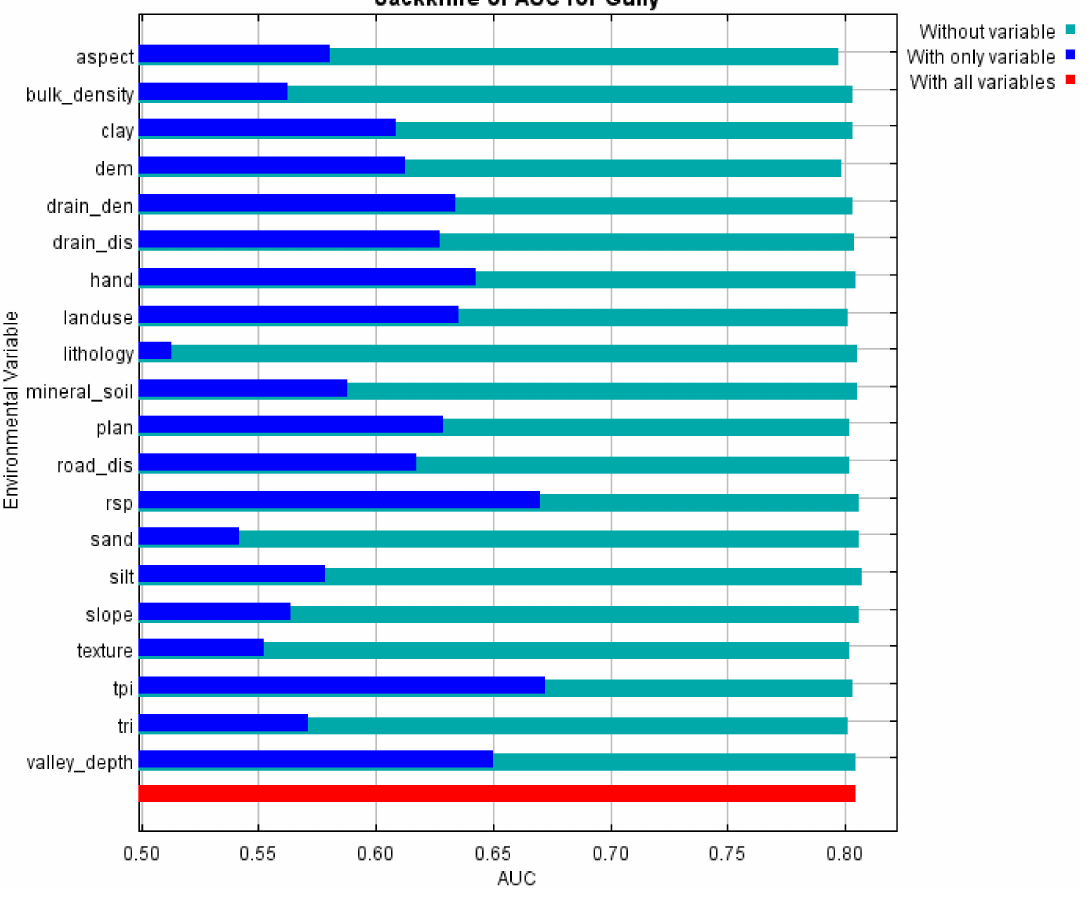
Figure 10. Jackknife test for important